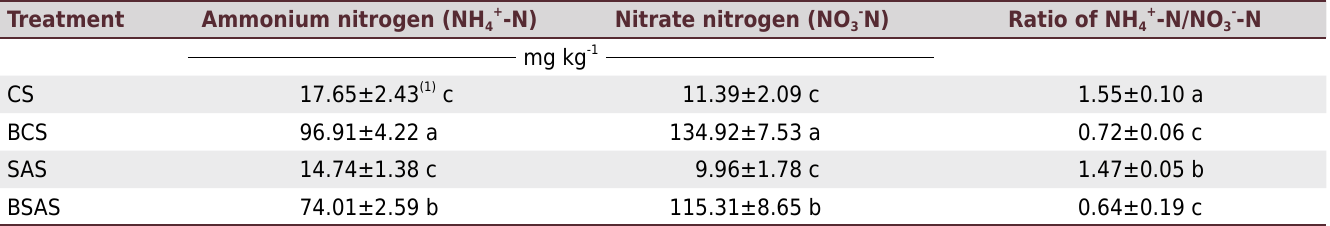
Table 3. Dynamic changes of soil ammonium nitrogen (A, NH 4+ -N), nitrate nitrogen (B, NO 3- -N), and the ratio of NH 4+ -N/NO 3 − -N (C) in biochar application